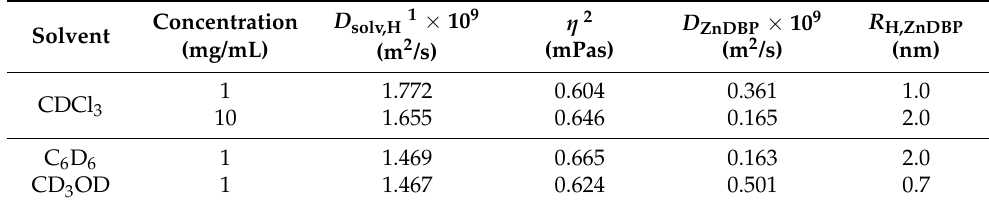
Table 3. The results of 1 H DOSY NMR measurements carried out at 25 ◦ C for the solutions of ZnDBP in perdeuterated solvents of different